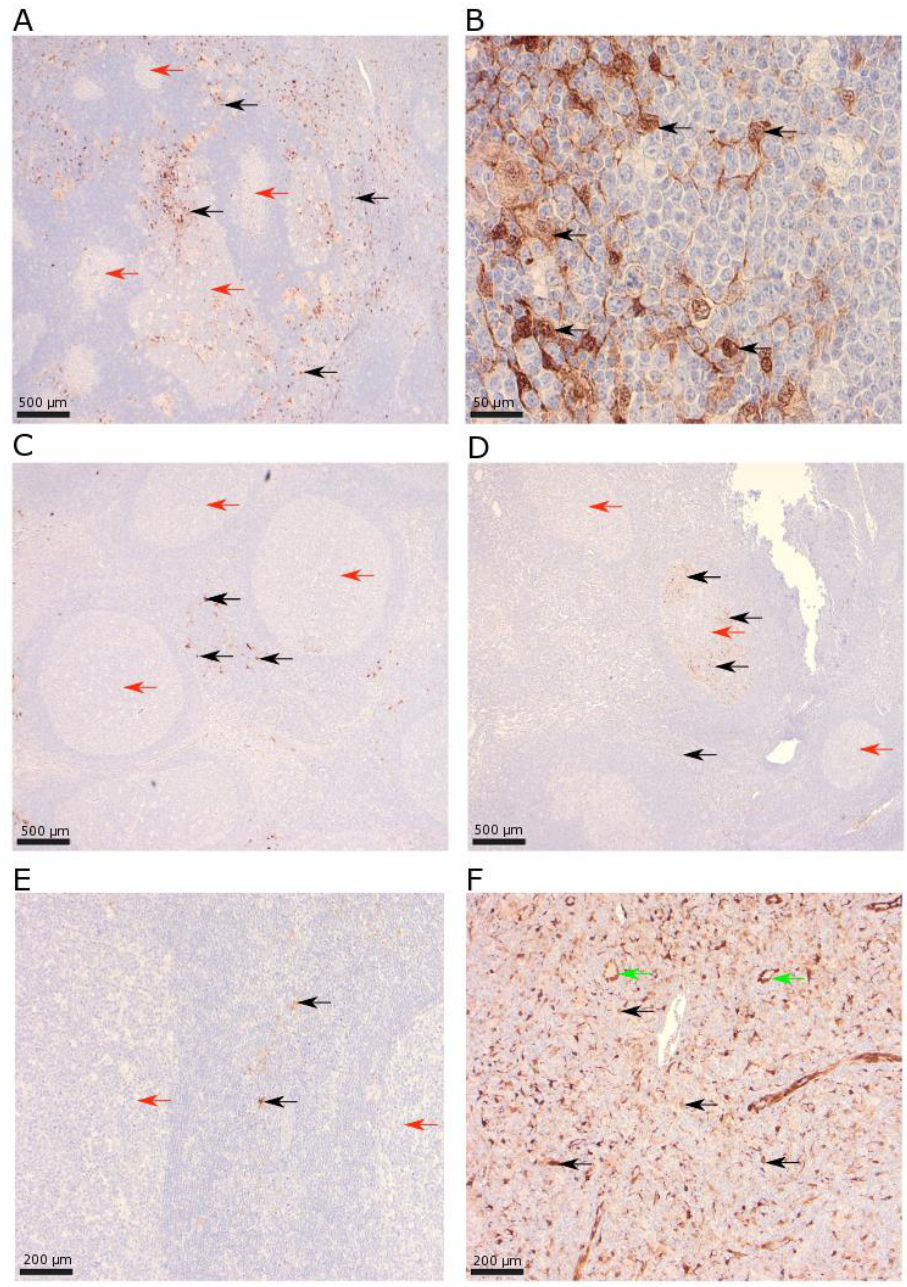
Figure 2. IDO1 in benign lymphadenopathies (rabbit polyclonal antibody HPA023149 (Atlas Antibodies AB, Stockholm, Sweden)) from patients with autoimmune diseases ( C , F ) and without autoimmune diseases ( A , B , D , E ). ( A , B ) Lymph node with high amounts of IDO1+ cells in both follicular (20%) and interfollicular (20%) areas (magnification 40 × and 400 × , respectively). ( C ) Low amount of follicular (0%) and intermediate amount of interfollicular (5%) IDO1+ cells (magnification 40 × ). ( D ) Intermediate amount of interfollicular (5%) and high amount of follicular (10%) IDO1+ cells in one germinal center, with no IDO1+ cells in other germinal centers (magnification 40 × ). ( E ) Low amounts of IDO1+ cells in both follicular (0%) and interfollicular (2%) areas (magnification 100 × ). ( F ) High amount of follicular (5%) and a very high amount of interfollicular (75%) IDO1+ cells. Note also endothelial IDO1+ cells (magnification 100 × ). IDO1+ leukocytes = black arrow, follicular areas = red arrow, IDO1+ endothelial cells = green